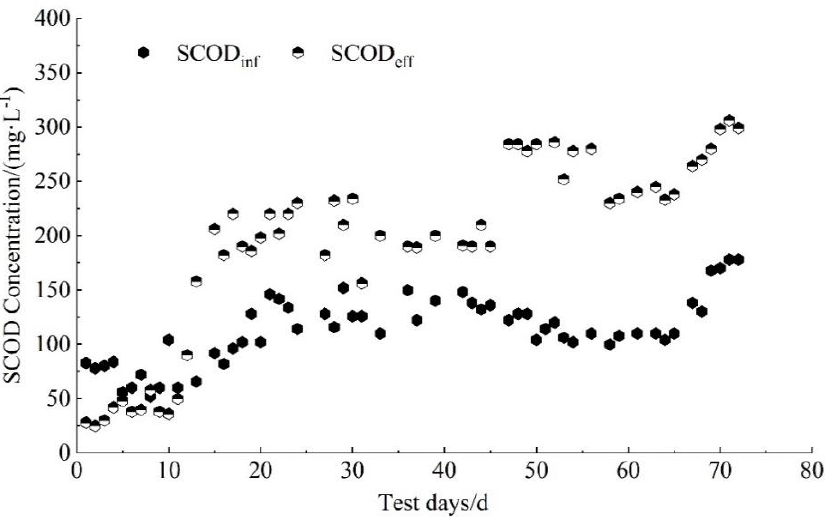
Figure 5. Changes in SCOD during the initiation of partial nitrosation process. Table 2. Microbial community richness and diversity index.